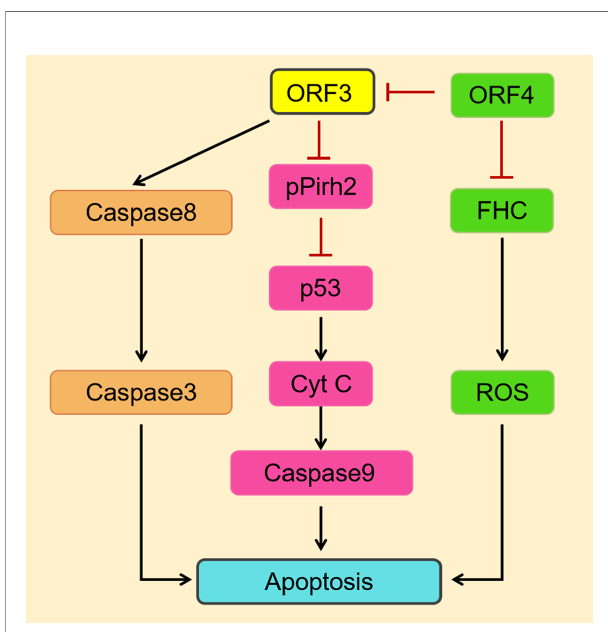
FIGURE 4 | A simulation model describes the mechanisms of PCV2 ORF3- induced apoptosis (Pan et al., 2018). On the one hand, the PCV2 ORF3 protein induces apoptosis through the death receptor pathway via the activation of caspase 8 and caspase 3. On the other hand, the interaction of the ORF3 protein and pPirh2 causes the accumulation of p53 and then upregulates factors downstream of p53 to induce apoptosis. The ORF4 protein inhibits apoptosis by suppressing the activation of ORF3. And by interacting with FHC, which has been suggested to prevent cells from undergoing apoptosis induced by a variety of stimuli, it can ultimately suppress apoptosis by inhibiting the production of